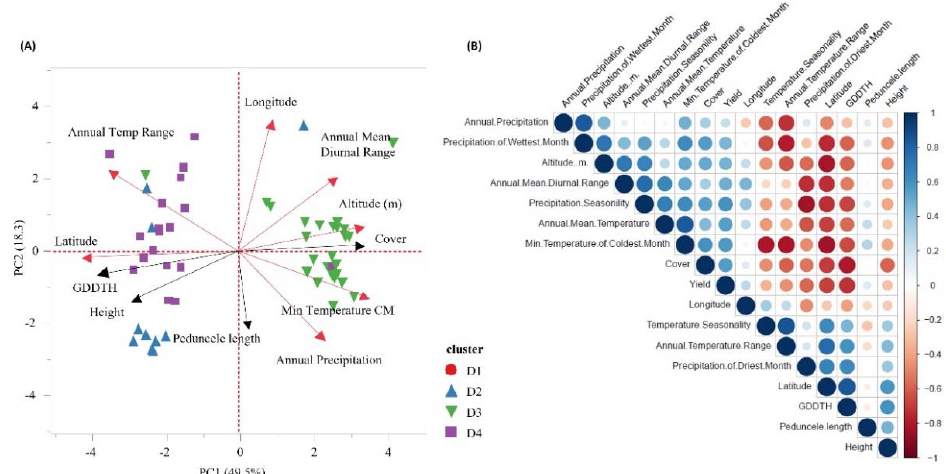
Figure 6. ( A ) Principal component analysis (PCA) of eco-geographic and phenotypic data. PCA of phenotypic (black arrow: cover, height, GDDTH) and eco-geographic traits (red arrow: annual temperature range, latitude, annual precipitation, minimum temperature of the coldest month (CM), altitude (m), annual mean diurnal range, and longitude). Shape and color represent accessions membership to different genetic clusters D1( ● ), D2( ▲ ), D3( ▼ ), D4( ■ ). ( B ) Pearson correlation matrix of all tested traits. Bold values represent statistical significance ( p ≤ 0.05). Colors indicate the level of correlation (r) from positive correlation (blue) to negative (red). Circle size indicates the level of significance, and the bigger and darker color dot represents significant correlations at p < 0.05.